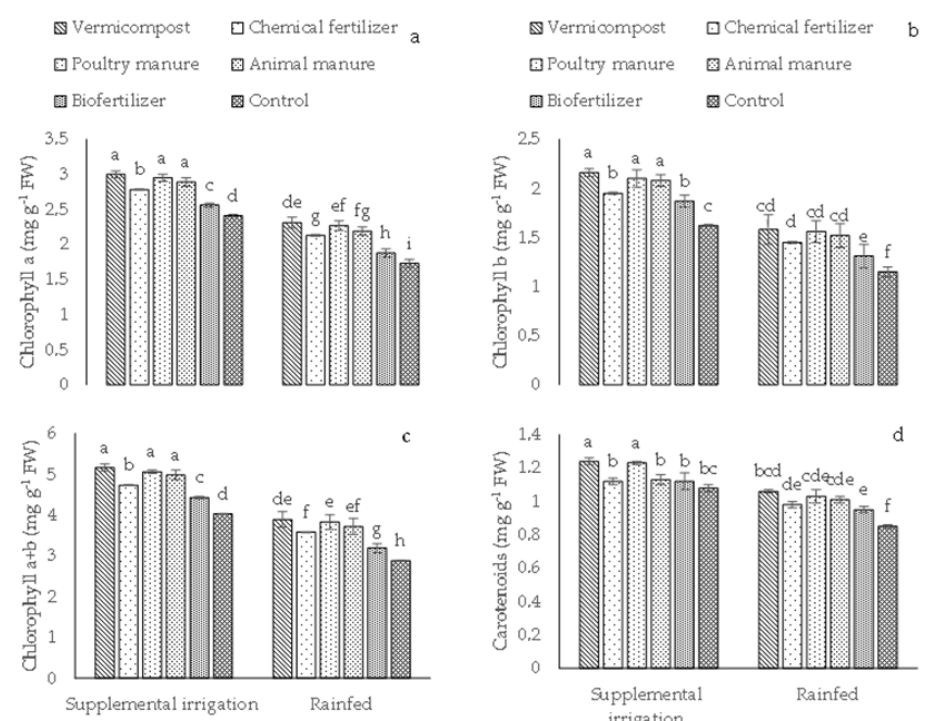
Figure 1. Means ( ± Standard deviation, SD) comparison for the interaction impacts of fertilizer and irrigation conditions on chlorophyll a ( a ), chlorophyll b ( b ), chlorophyll a+b ( c ), and carotenoids ( d ). FW: fresh weight. The means with unlike letters vary significantly at p ≤ 0.05 based on Tukey’s HSD